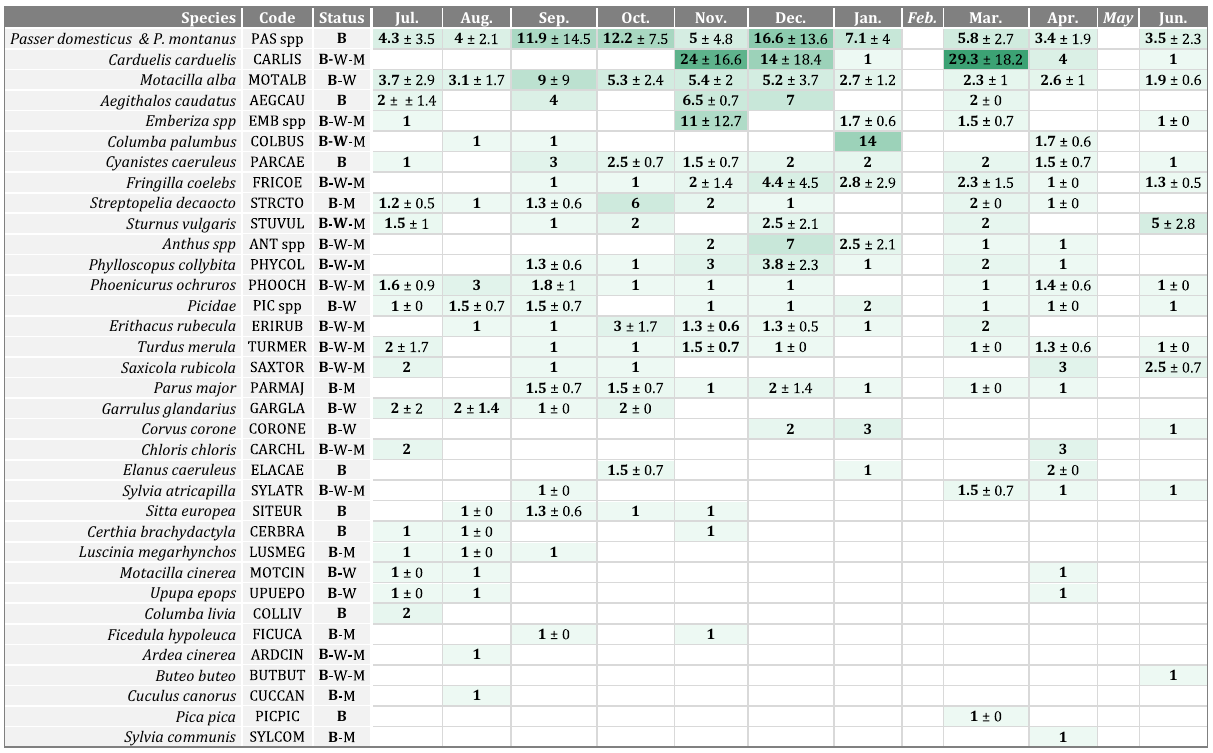
Table 1. Monthly mean (± standard deviation) of minimum number of individuals per species, listed in descending order of cumulative means. The darker the cell, the higher the mean. National population status of each species is taken from UICN France (2016) 49 , indicated as breeding (B), wintering (W), migrant (M). A combination of statuses is indicated if different populations are present along the year, and figured in bold if the population is consistently evaluated and significant for the species according to UICN’s